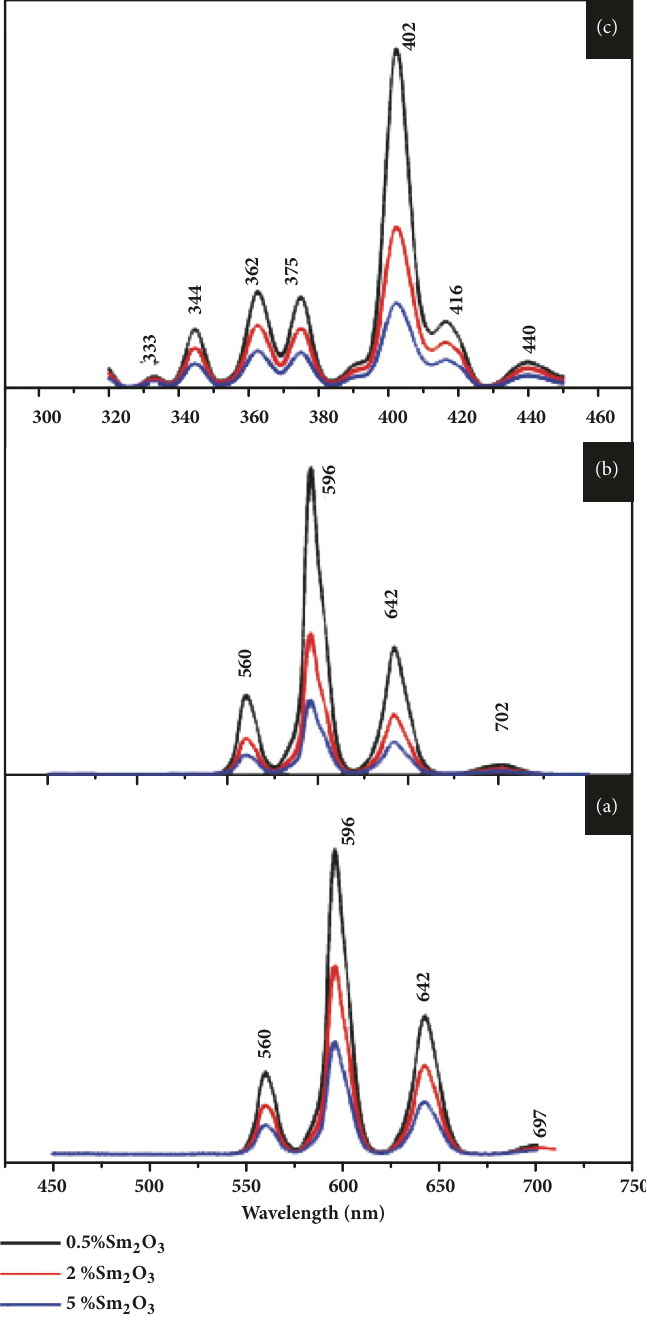
Figure 6: Photoluminescence spectra of Sm 2 O 3 -doped glasses: (a) emission at 365 nm, (b) emission at 𝜆 ex = 402nm, and (c) excitations at 𝜆 em =